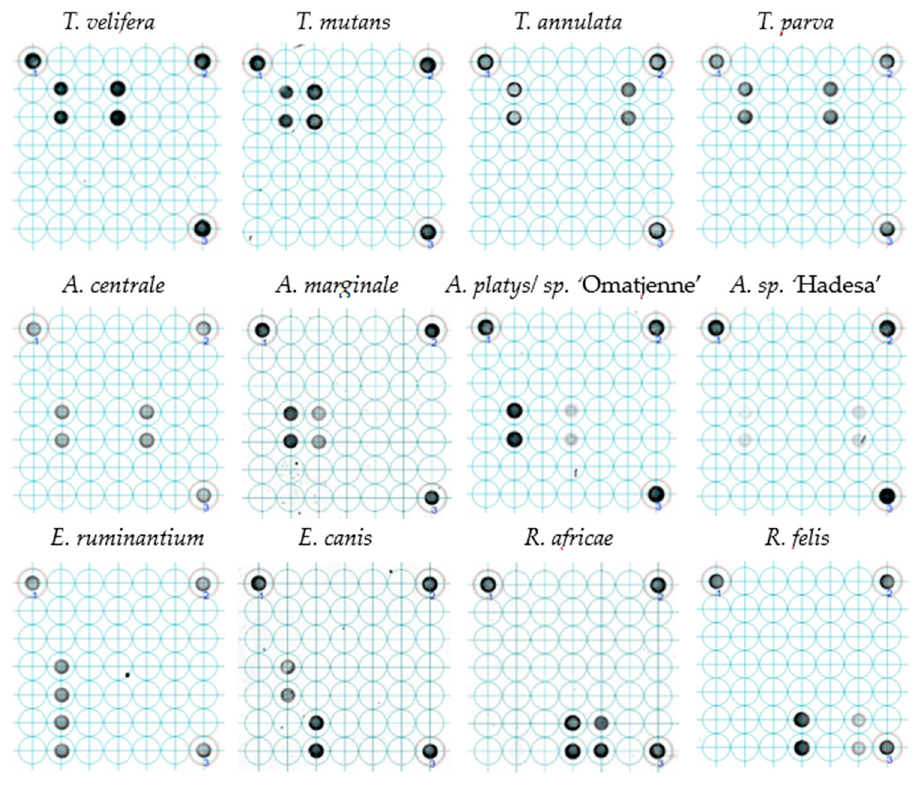
Figure 2. Probe hybridization of LCD-Array of tick-borne pathogens. The dark spots indicate hybridization of plasmids with species-specific inserts to the probe spotted on the array in duplicates. The faint spots indicate lower concentrations in the respective PCR products. The three spots in the corners are internal kit controls. For each of the tested positive controls (plasmids), the concentration came from the first dilution not producing a visible product in agarose gel.